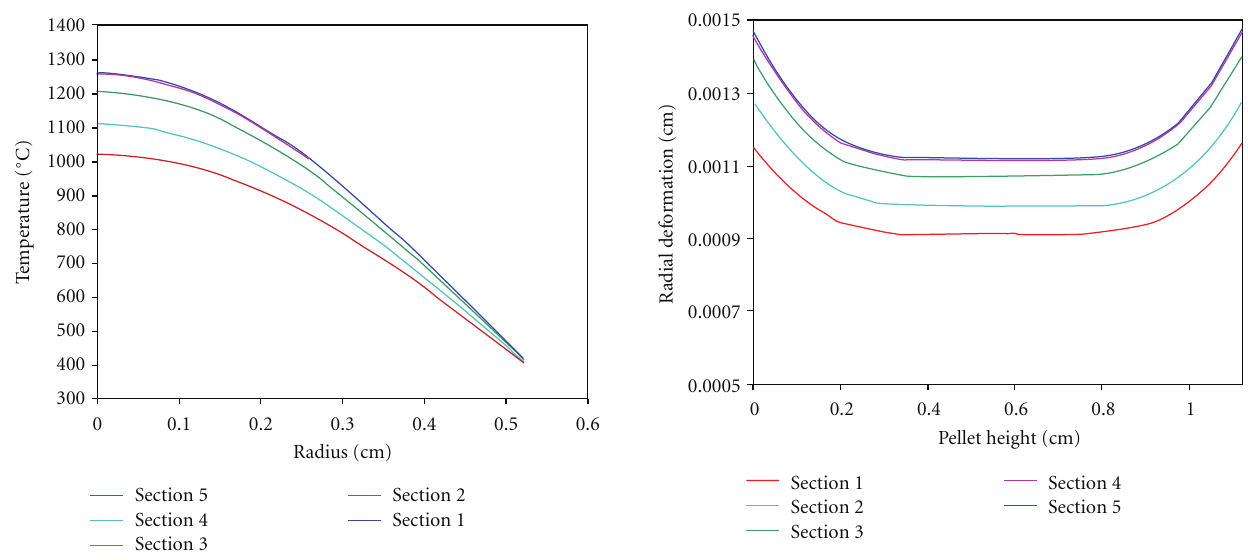
Figure 6: Temperature profile of the MOX fuel A.1.3 at the top power ramp at EOL (Section 1 at the top of the fuel rod due to the flipping before ramping).